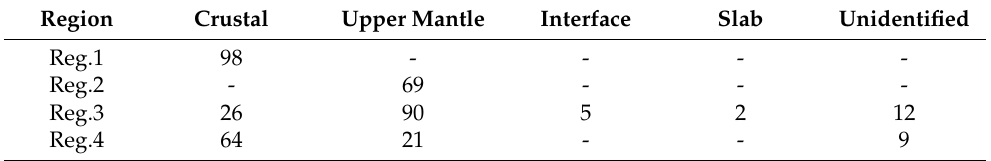
Figure 4. Distribution of 397 earthquakes (circles) considered in this study. Table 1. Type and number of earthquakes included in each